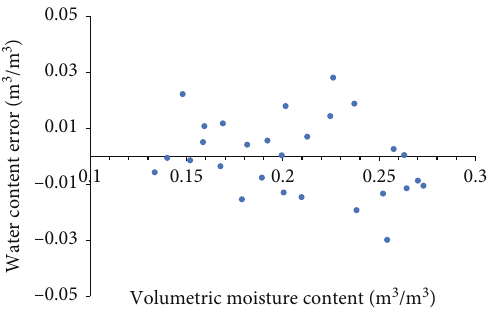
Figure 15: The relative errors between calculated water contents and measured water contents by the fi tting relational formula.